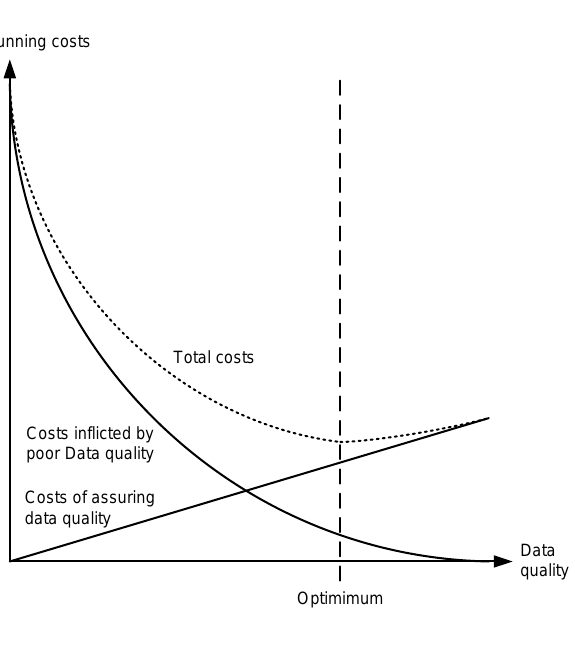
Figure 1. “Total costs incurred by data quality on the